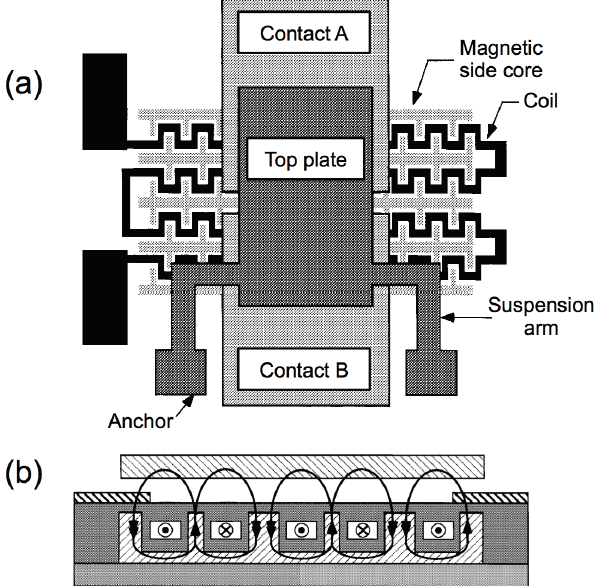
Figure 9. Top view ( a ) and cross-section ( b ) of the device presented by Taylor et al . [132]. The magnetic movable plate is attracted to the substrate when a current is passed in the meander coil to generate a magnetic pulling force. Reprinted with permission from [132]. Copyright 1998